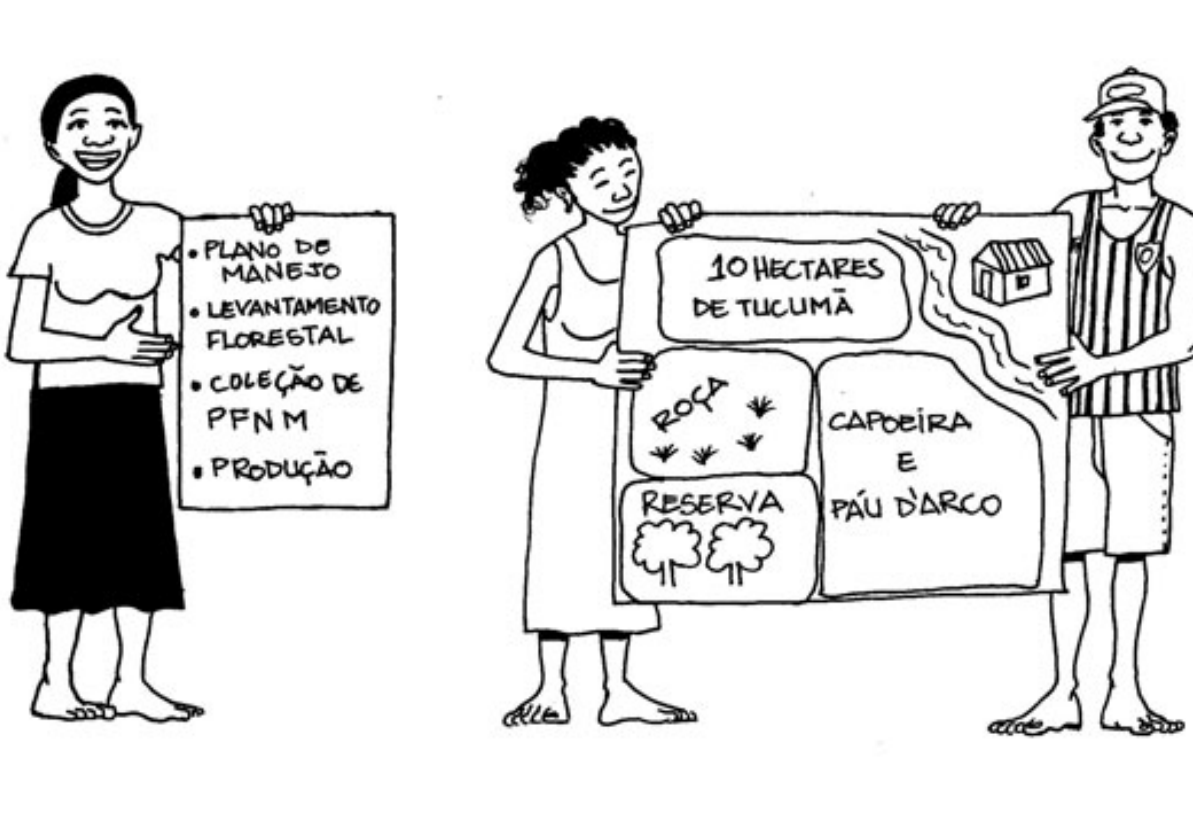
Fig. 15 . Exchanges among rural communities can provide critical information for more informed land use decision making. Source: Shanley and Medina